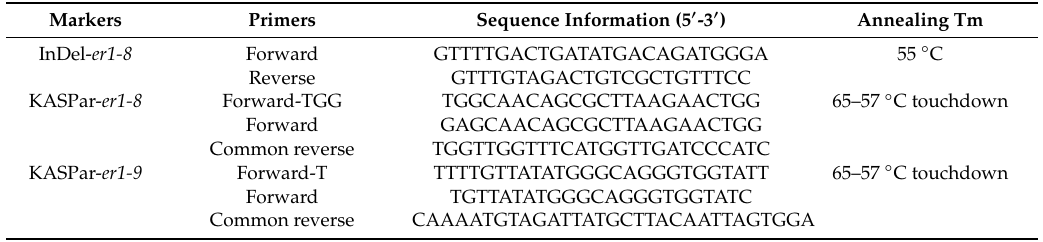
Table 3. Sequence information for the indel and Kompetitive allele-specific PCR (KASPar) markers specific to er1 -8, and for the KASPar marker specific to er1